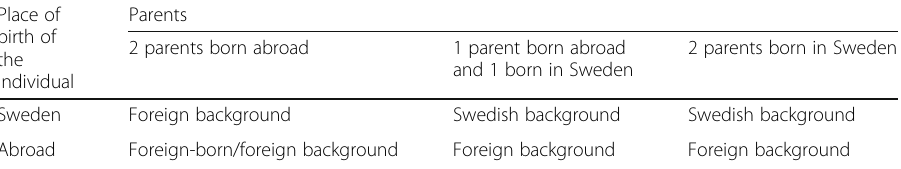
Table 3 Correspondence between concepts used by Statistics Sweden and the respective population groups Place of birth